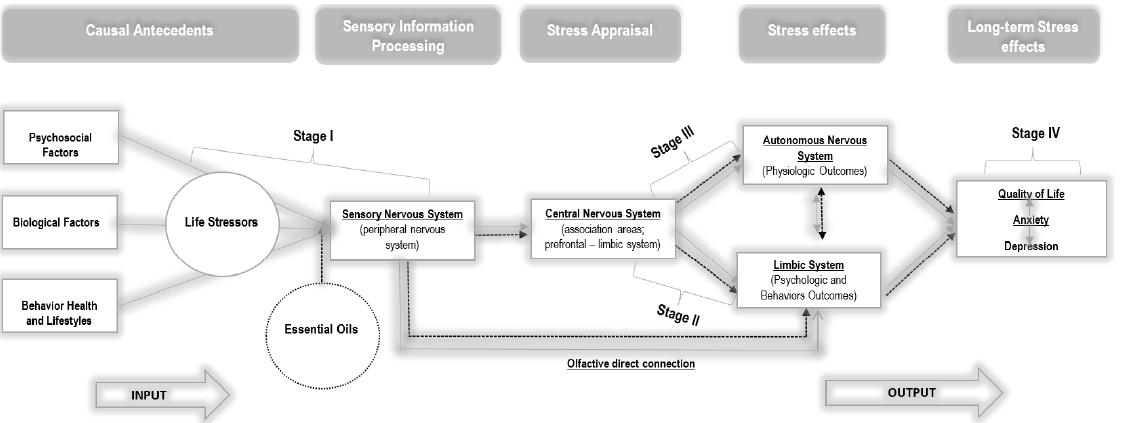
Figure 5. Neuro-psycho-physiological model of stress and coping for the experimental group. Adapted Transactional Model of Stress and Coping by Lazarus and Folkman [27].